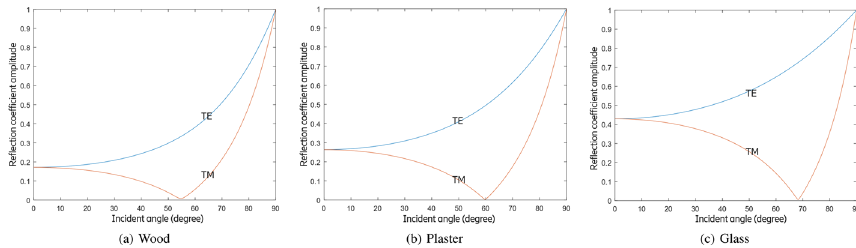
Fig. 6 Reflection coefficient amplitudes for air/wood, air/plaster, and air/glass interfaces at 100